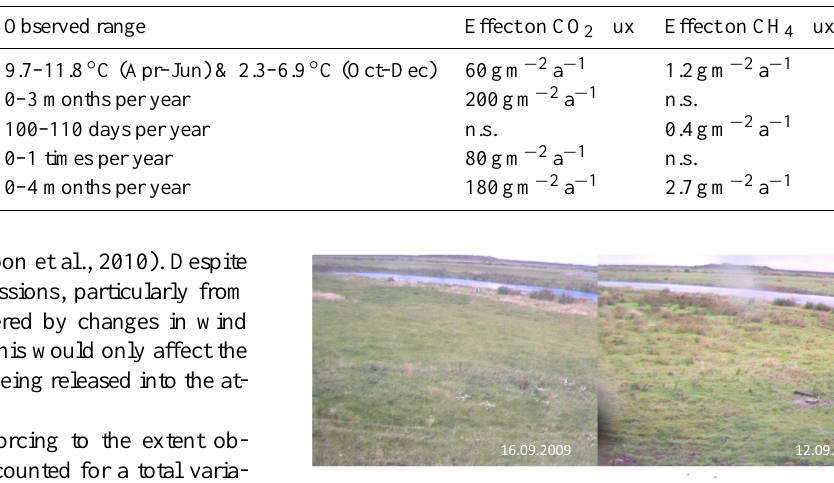
Table 6. Sensitivity of GHG fluxes to meteorological forcing and management activities. See text for details about how the effects were quantified.